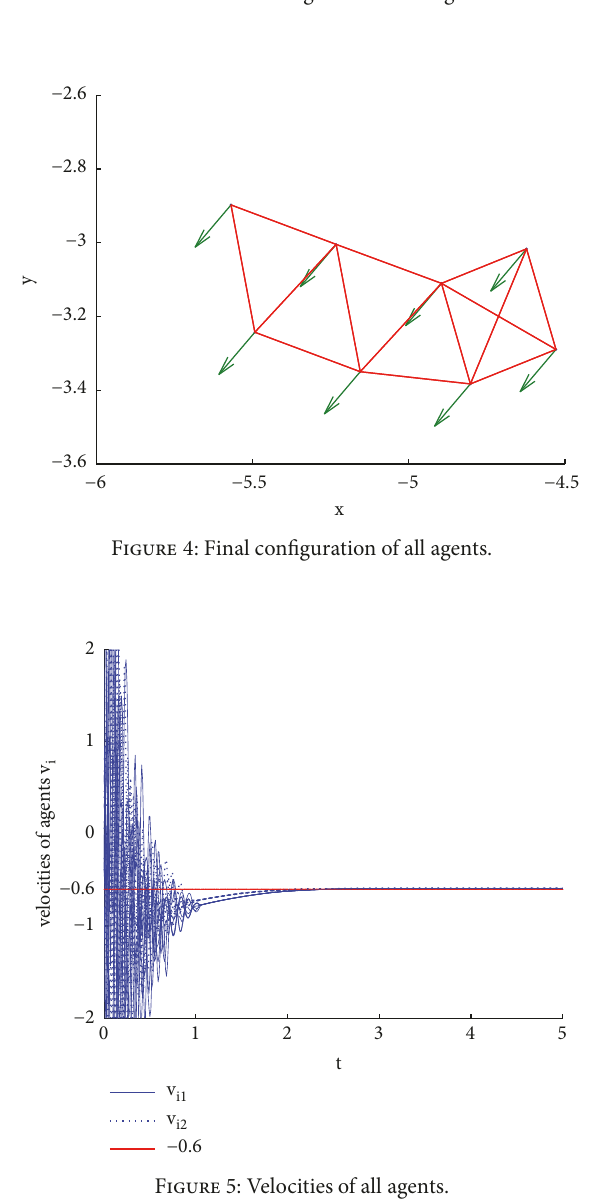
Figure 3: Initial configuration of all agents.